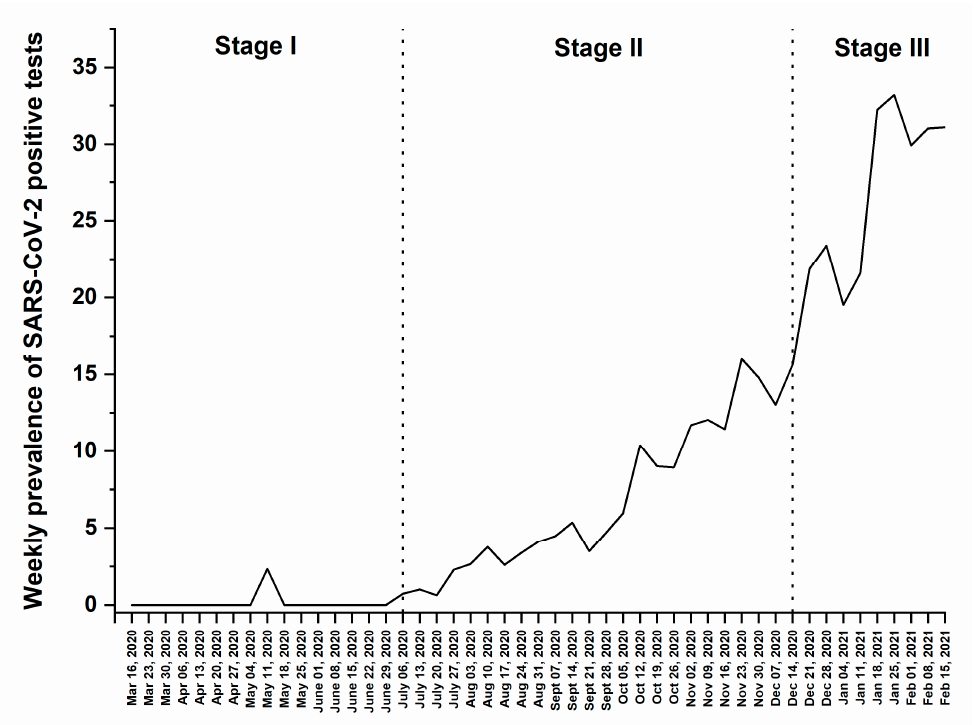
Figure 2. Weekly prevalence of SARS-CoV-2 positive cases between 16 March 2020 and 21 Febru- ary 2021.